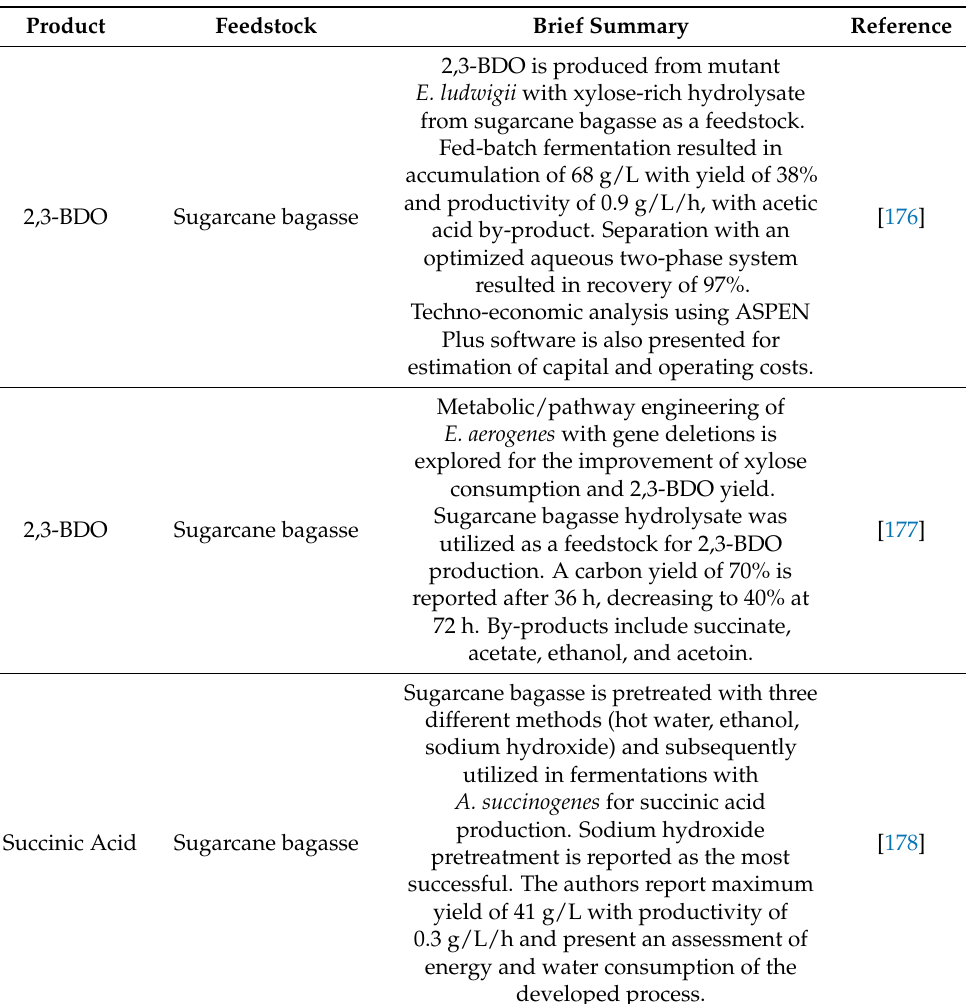
Table 2. Details on reported applications of sugar crop lignocellulosic byproducts utilized in the production of highlighted C4 platform